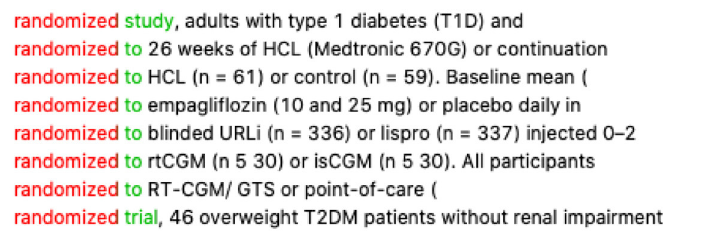
FIGURE7 Concordance lines of